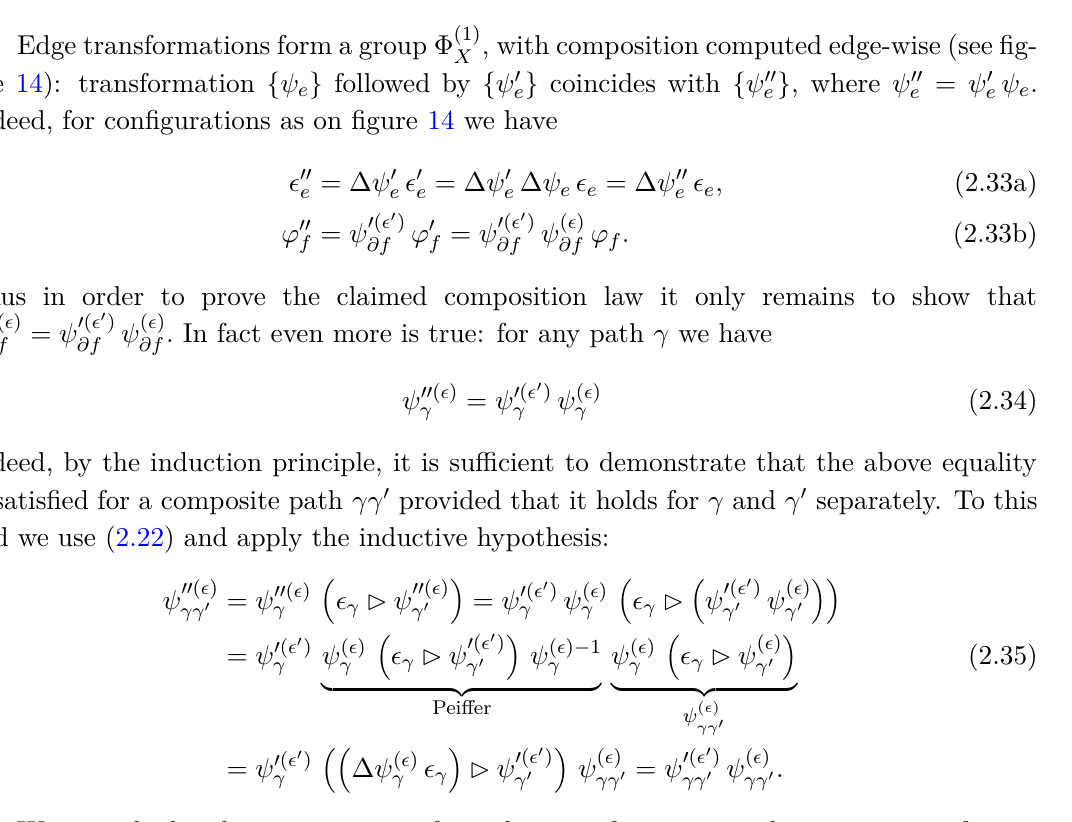
n Φ (1) generated by X X